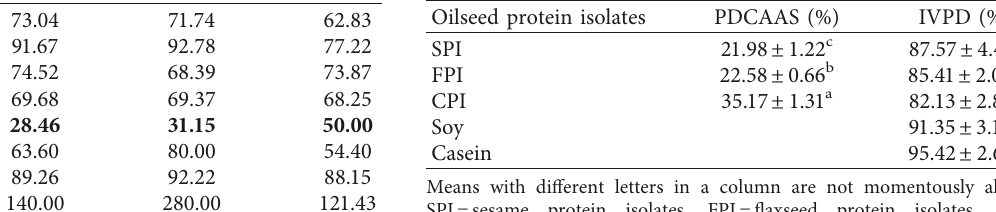
Table 3: Amino acid score for defatted oilseed protein isolates. Amino acid